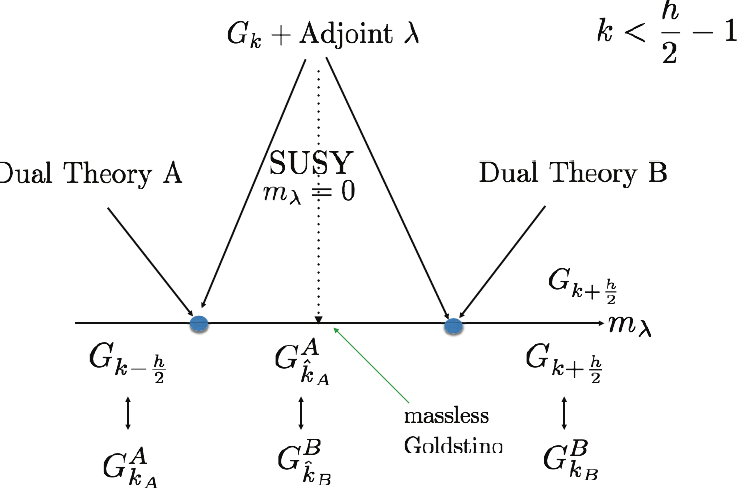
− 1. The system has three phases. 2 = 0 is in the interior of this λ